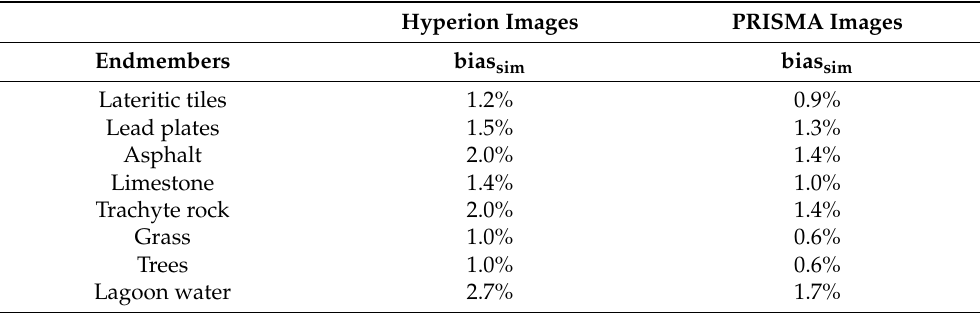
Table 3. Biases in the simulation of the real images estimated with ∆ aSSMn k